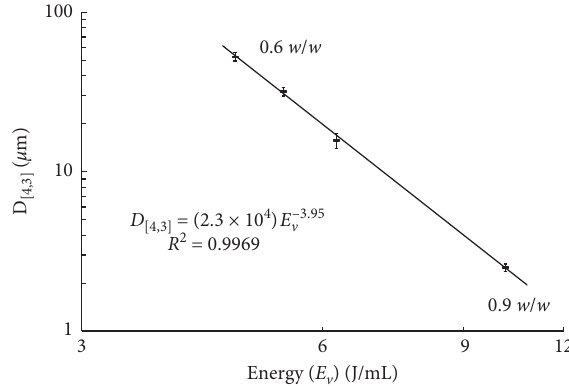
Figure 4: Droplet mean diameter D [4, 3] µ m (in log scale) as a function of the energy incorporated per volume (in log scale) for O/ W emulsions within a concentration range of 60%–90% w / w . The exponential relationship between the droplet size and the incor- porated energy sheds light on additional reasons why the energy requirement increases with